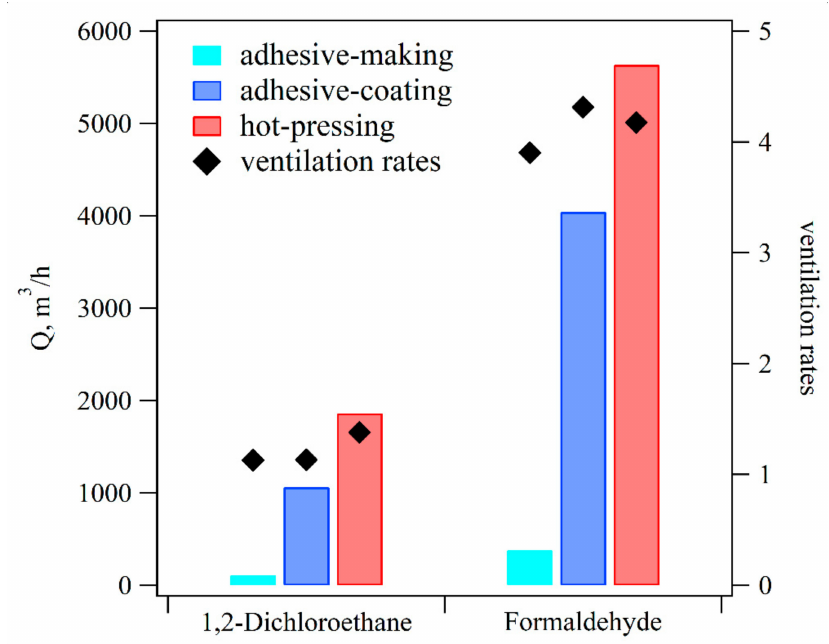
Figure 8. Air supply volume (Q) and ventilation rates of formaldehyde and 1,2-dichloroethane from three processes in the plywood manufacturing